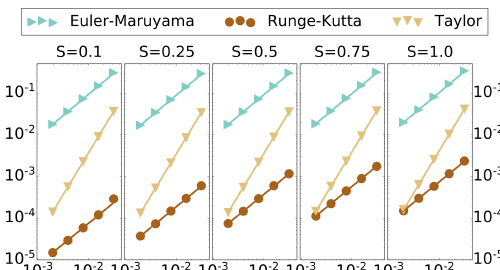
Figure 1. Strong convergence benchmark. Vertical axis – discretiza- tion error, log scale. Horizontal axis – step size, log scale. Diffusion level s . Length of time T = 0 . 125.